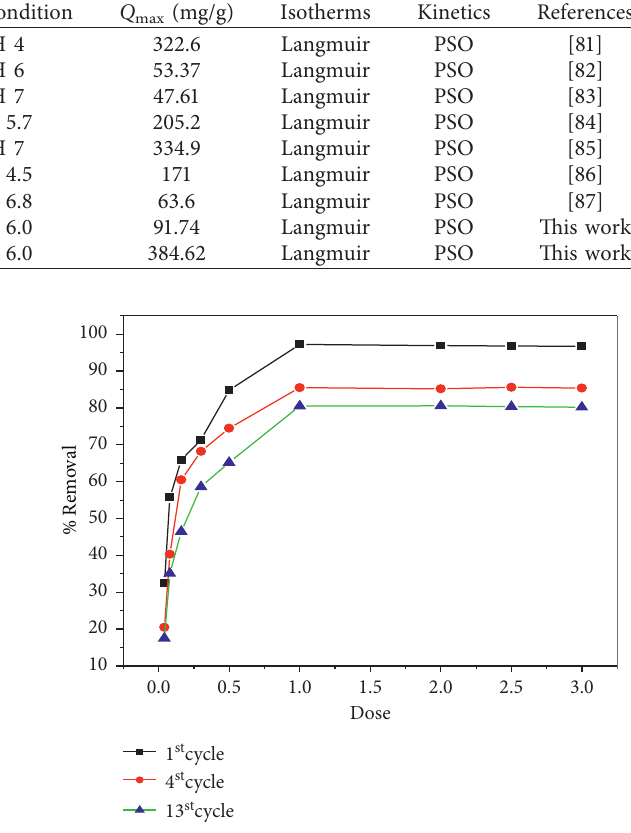
Figure 10: Percentage of Pb(II) ions removal after different cycles (1st, 4th, and 13th) by NaIO 4 -CNM